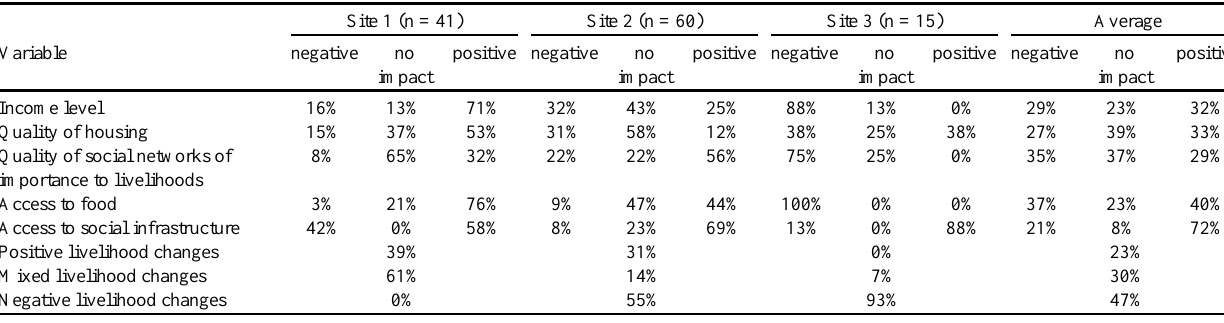
Table 10 . Perceived social-economic impacts among former landowners and customary users.